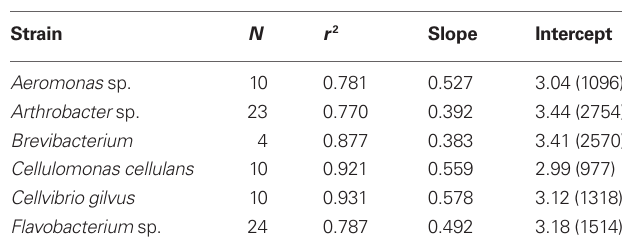
Table 2 | Molar C:P SMA regression